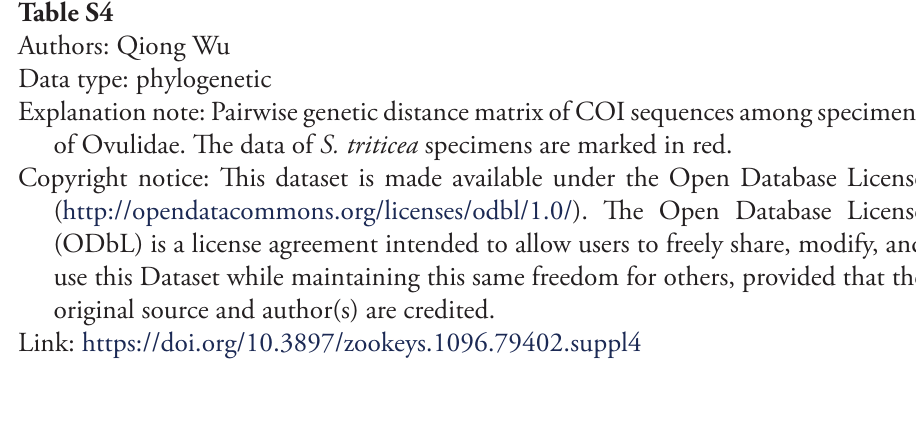
Data type: phylogenetic